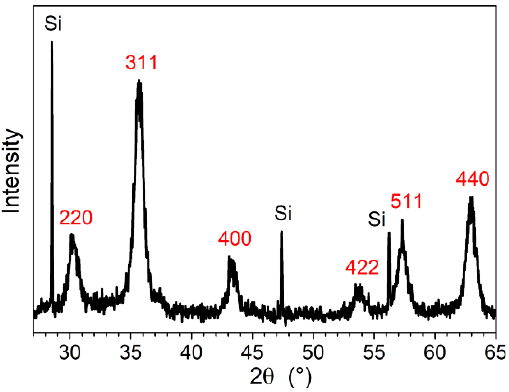
Figure 2. PXRD pattern of iron oxide NPs. The peaks are labeled with the hkl indices of the spinel structure. Si powder was used as a